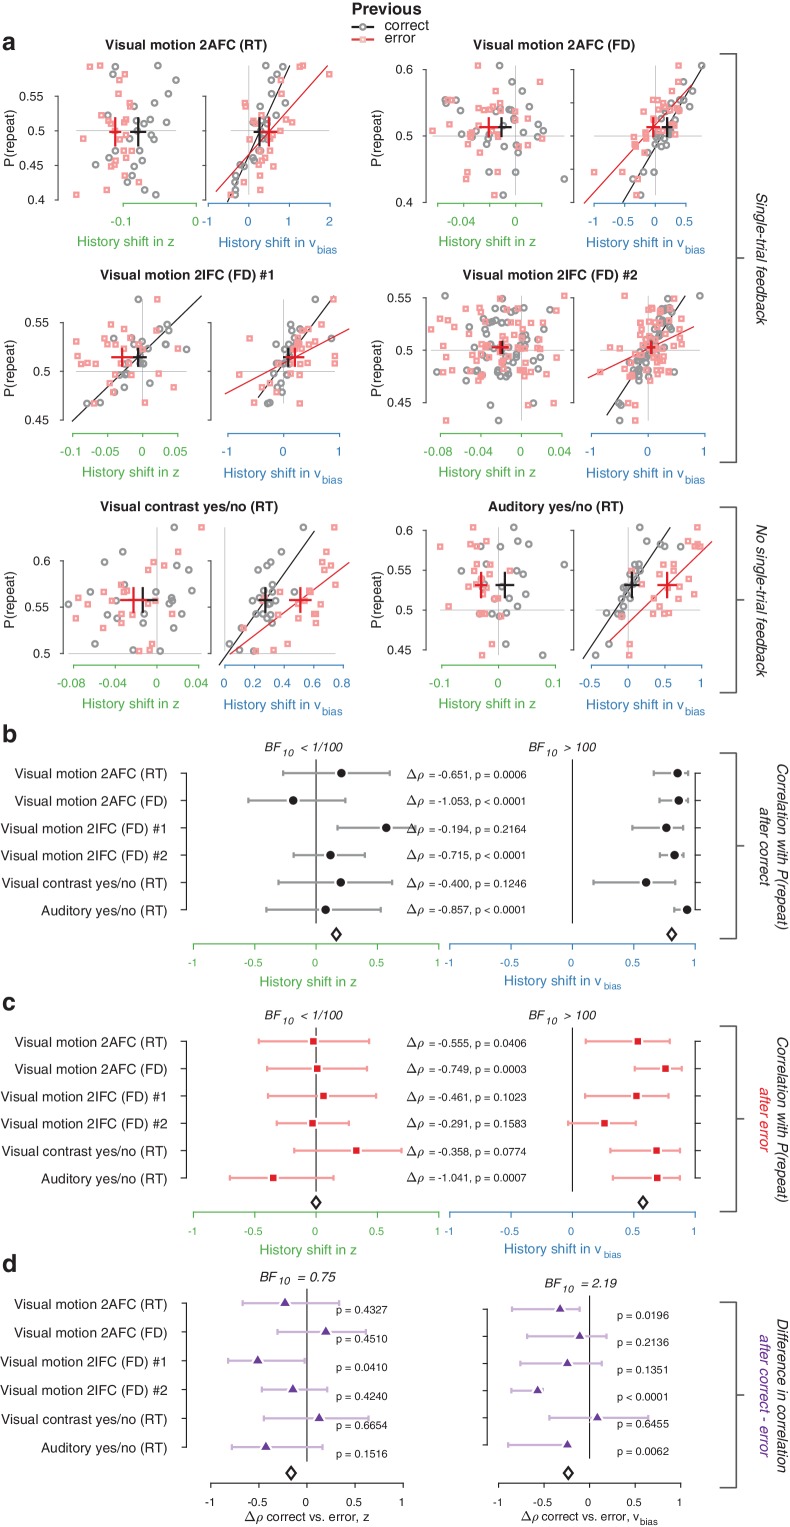
History shift in drift bias explains individual choice behavior after both error and correct decisions.As in Figure 4, but separately following correct (black) and error (red) trials. Post-correct trials were randomly subsampled to match the trial numbers of post-error trials. (a) Relationship between repetition probability and history shifts in starting point and drift bias, separately computed for trials following correct (black circles) and error (red squares) responses. (b) Summary of correlations (as in Figure 4c) for trials following a correct response. Error bars indicate the 95% confidence interval of the correlation coefficient. (c) Summary of correlations (as in Figure 4c) for trials following an error response. (d) Difference in correlation coefficient between post-correct and post-error trials, per dataset and parameter. Δρ quantifies the degree to which the two DDM parameters are differentially able to predict individual choice repetition (p-values from Steiger’s test). The black diamond indicates the mean correlation coefficient across datasets. The Bayes factor (BF10) quantifies the relative evidence for the alternative over the null hypothesis, with values < 1 indicating evidence for the null hypothesis of no correlation, and >1 indicating evidence for a correlation.